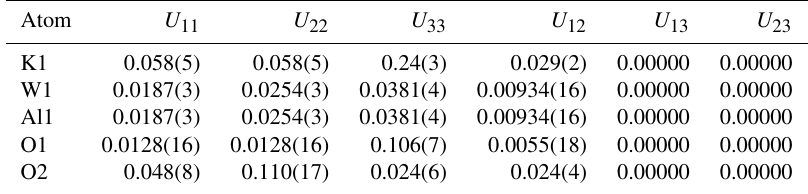
Table 5. Anisotropic displacement parameters (Å 2 × 10 3 ) of wumuite.